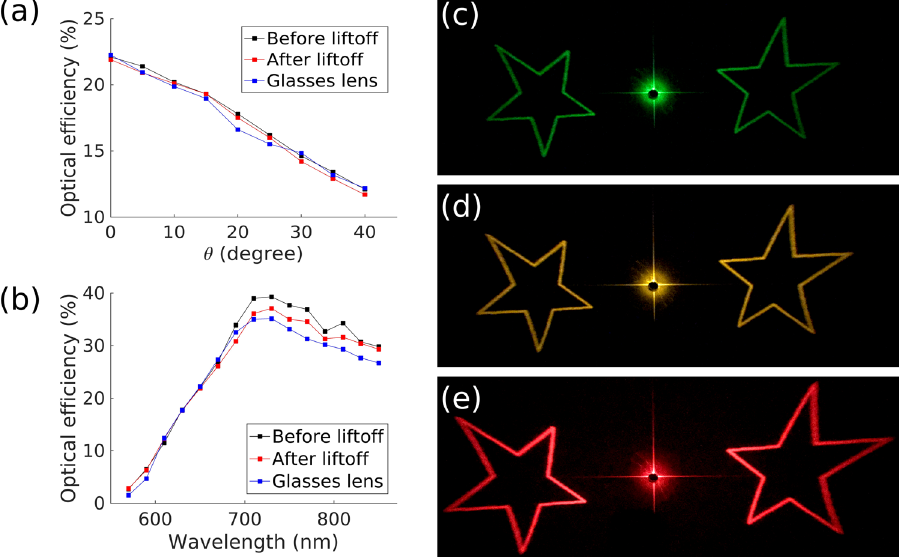
Figure 5. Measured efficiency for right handed incident circular polarization vs ( a ) the angle between the normal to the surface of the MS and the incident beam for λ = 650 nm and ( b ) the wavelength of the beam for normal incidence. Experimentally obtained images after lift-off for the light beams at ( c ) 570 nm, ( d ) 590 nm, and ( e ) 690 nm. These images were taken with right handed circular polarization at normal incidence.